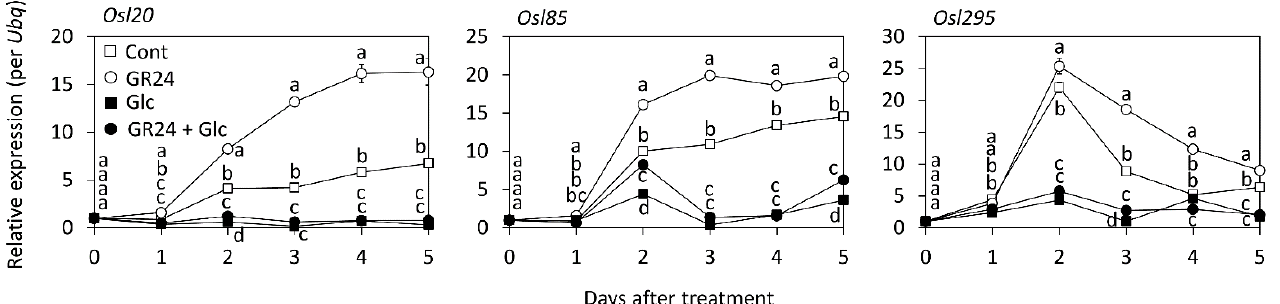
Figure 3. Effects of GR24 and glucose (Glc) on the transcript levels of senescence-associated genes. Rice leaf segments were treated with 1 µM GR24 and 1% Glc in a 12-well plate at 25 °C in dark. The control (Cont) was treated without GR24 and Glc. Transcript accumulations of Osl20 (left), Osl85 (middle), and Osl295 (right) were measured by using qRT-PCR. Expression level at day 0 after the treatment in each gene was standardized. Values and bars represent means ± SD ( n = 3). Each biological sample had two technical replicates. Letters show a significant difference ( p < 0.05) as determined by Tukey’s HSD test at the same time point.